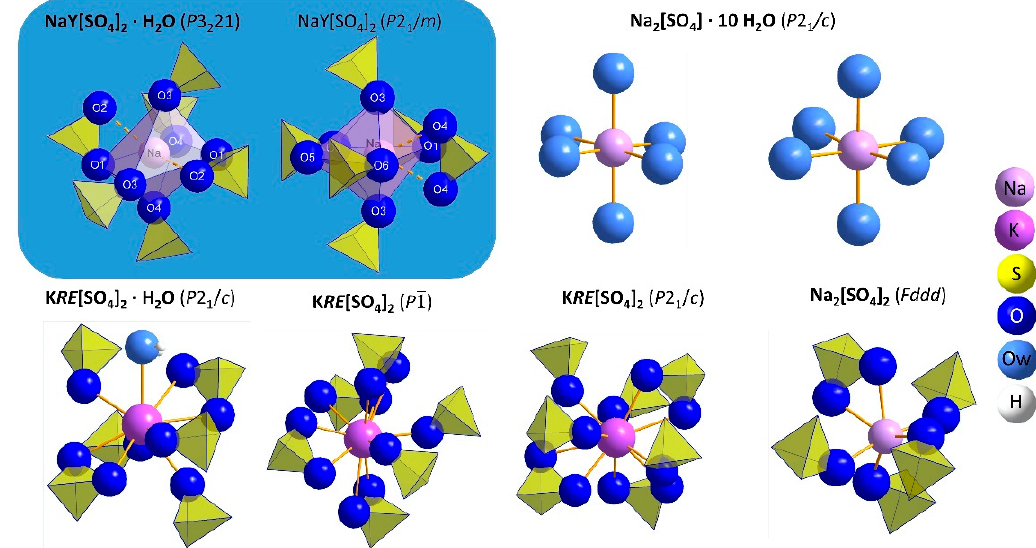
Figure 6. Coordination spheres of the alkali-metal cations ( A = Na and K) in different oxosulfates. The blue box contains the title compounds NaY[SO 4 ] 2 · H 2 O and NaY[SO 4 ] 2 .